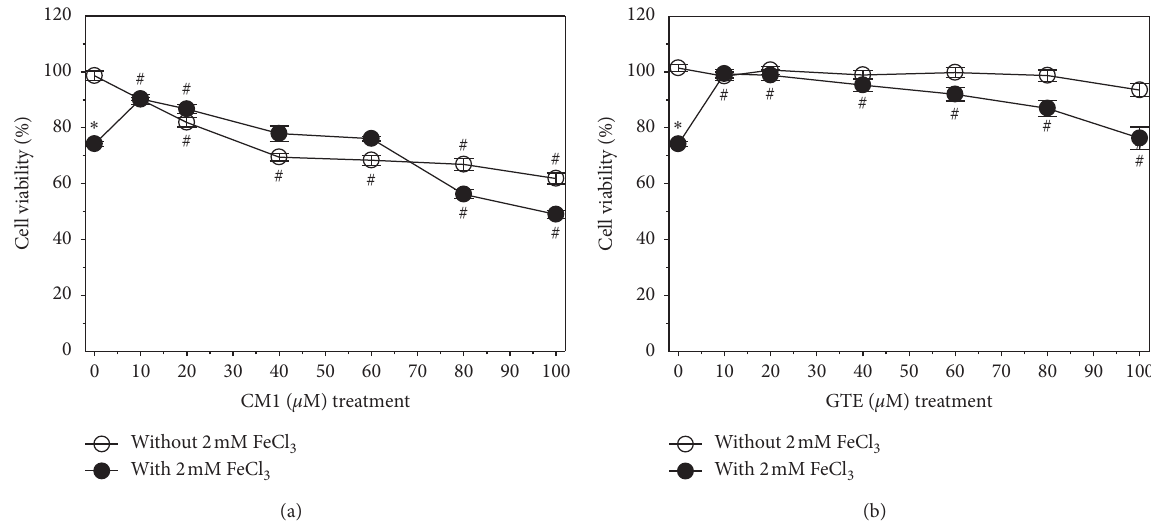
Figure 1: Viability of SH-SY5Y cells after being exposed to treatments with or without 2 mM FeCl 3 . Cells were then treated with CM1 (10–100 μ M) (a) and GTE (10, 20, 40, 60, 80, and 100 mg/mL equivalent to 5.24, 10.5, 20.48, 31.4, 41.9, and 52.4 μ M EGCG, respectively) (b) for 24 h. Data obtained from three independent duplicate experiments are expressed as mean ± SEM values. ∗ P < 0 . 05 when compared to the untreated cells without iron loading; # P < 0 . 05 when compared to the cells without